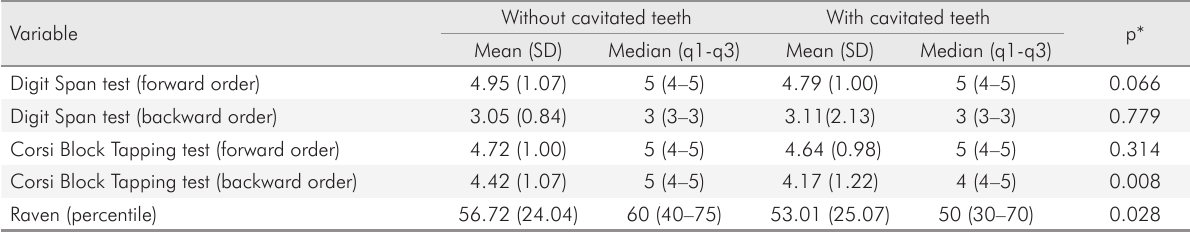
Table 4. Association between neuropsychological variables and occurrence of cavitated teeth.